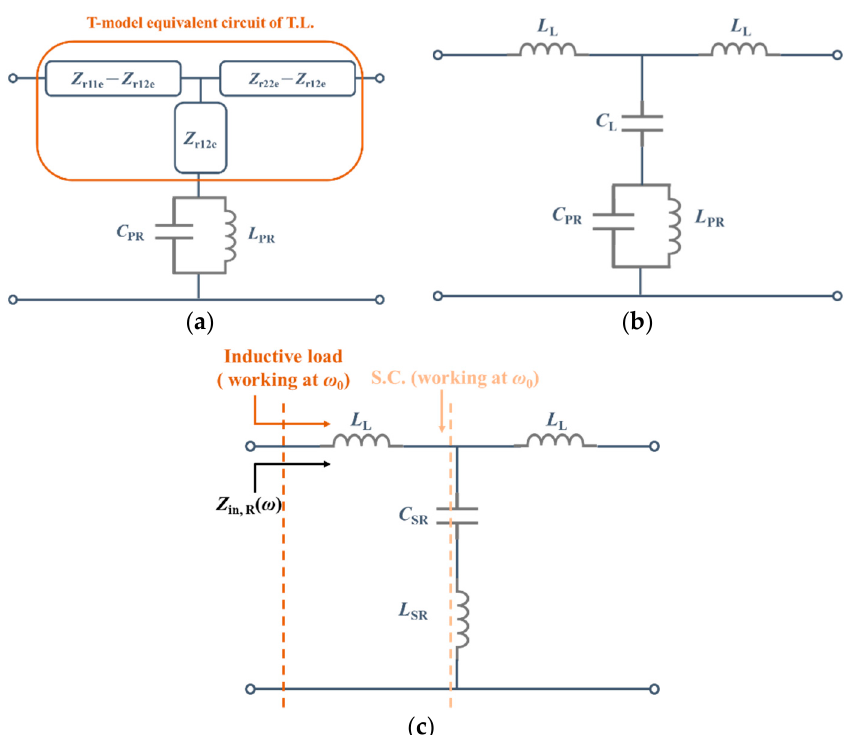
Figure 3. ( a ) The equivalent circuit of the Reflective Stage; ( b ) Use lumped component to represent the equivalent circuit; ( c ) The simplified equivalent circuit of the Reflective Stage.